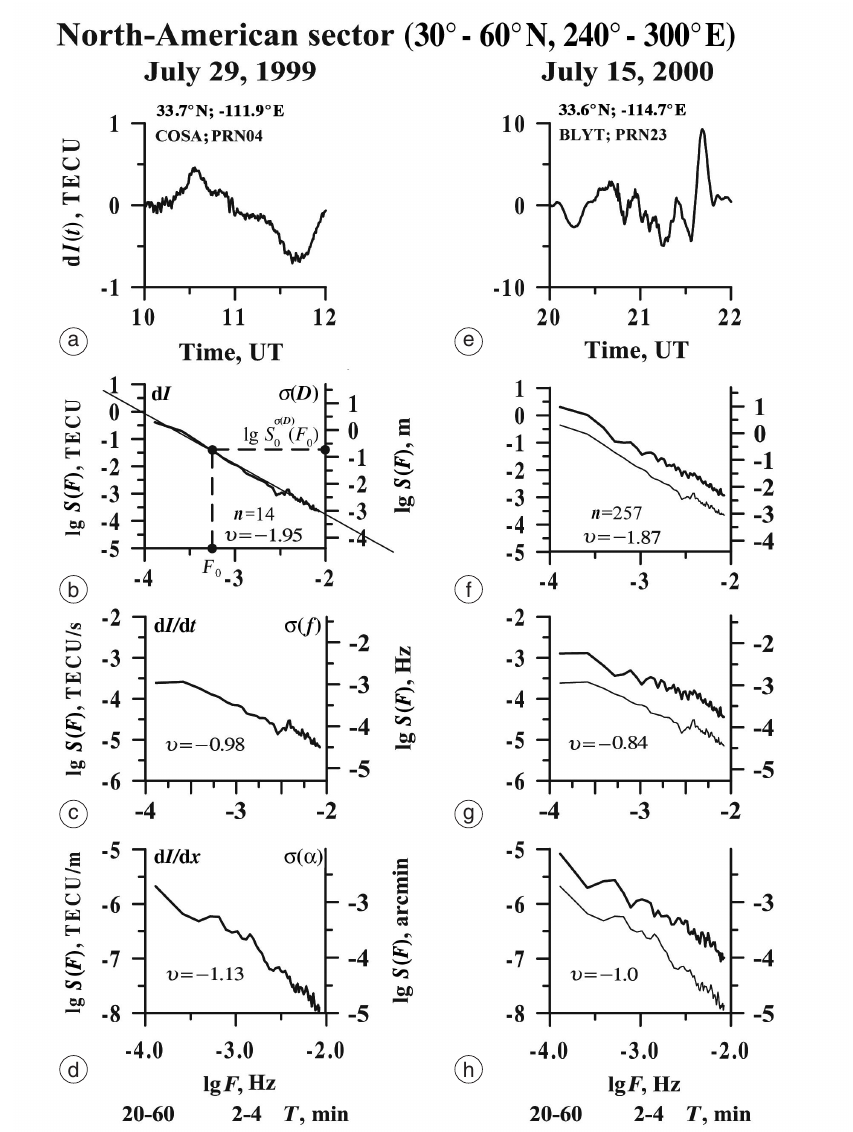
Fig. 5a-h. TEC variations dI ( t ) for the magnetically quiet day of July 29, 1999 (left, panel a) and a major mag- netic storm of July 15, 2000 (right, panel e) for North-American sector. These panels also show the names and coordinates of the COSA and BLYT stations and GPS satellite numbers (PRN). Panels b-d and f-h on a loga- rithmic scale present the amplitude spectra S ( F ) of TEC fluctuations and derivatives (left scale in the panels), and the fluctuation spectra of σ ( D ), σ ( f ) and σ ( α ) converted to the working frequency of 300 MHz (right pan- el). For comparison, spectra from the magnetically quiet day of July 29, 1999 are shown in panels f-h by the thin line. The range of fluctuation periods is shown in bold type along the abscissa axis of panels d,h. Panels b,e show the number n of GPS arrays. The power law character of the spectra is determined by the values of slopes ν . The thin black slant line in panel b is a fitted straight line of the power law